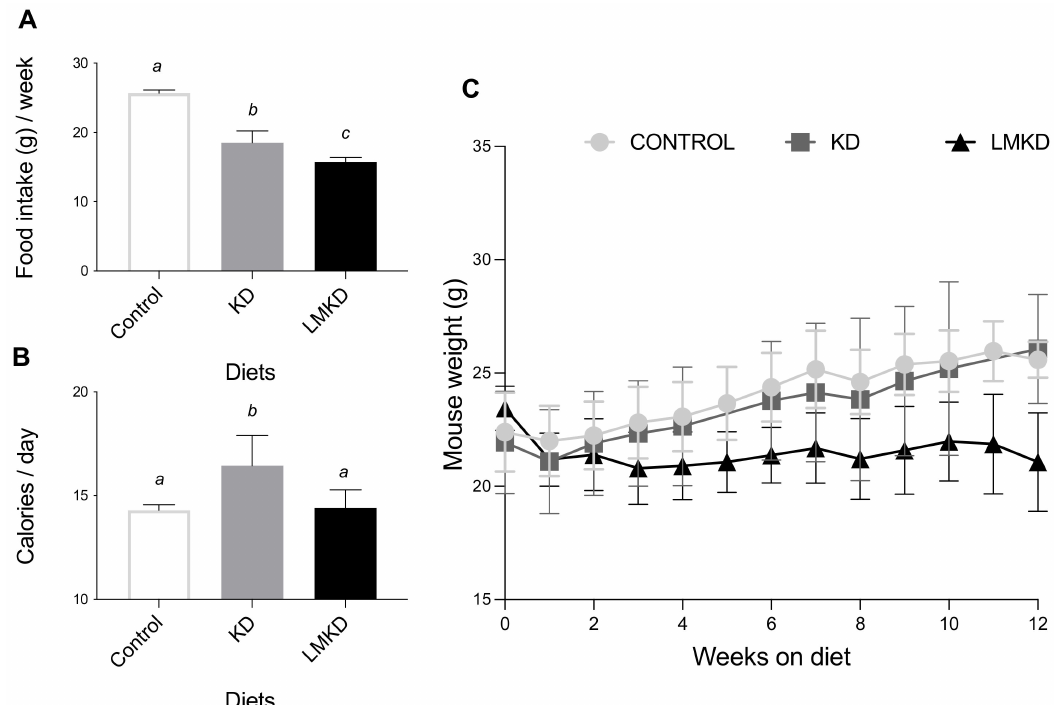
Figure 1. The effect of the experimental diets (ketogenic diet, KD; low methyl ketogenic diet, LMKD; and control diet) on food intake ( A ), calorie consumption ( B ) and animal growth ( C ). Data shown are the mean ± SD, n = 4–6/group. Means not sharing superscript letters differ by p <